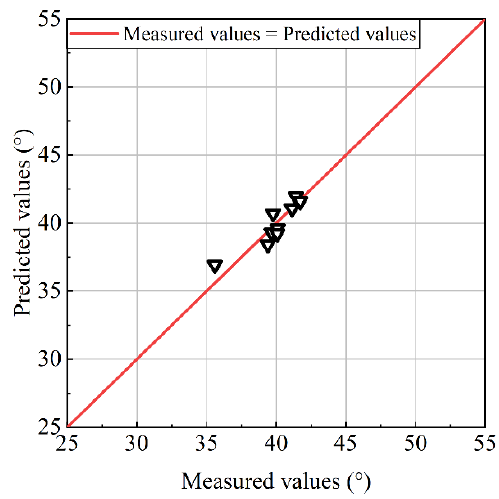
Figure 16. Measured and predicted values of the internal friction angle of rockfill materials.